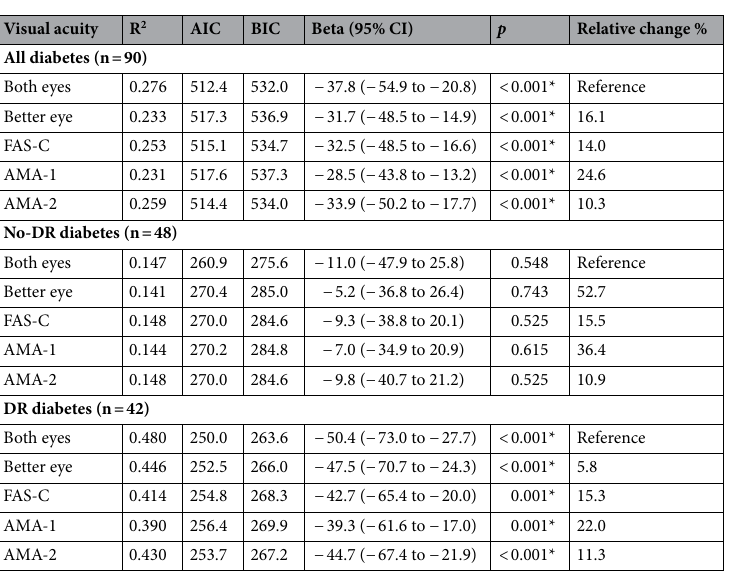
Table 4. Results of the multiple linear regression model and goodness-of-fit statistics of the different acuity models for the Rasch calibrated NEI VFQ-25 composite scores. AIC Akaike information criterion, BIC Bayesian information criterion, DR diabetic retinopathy, FVS‑C functional acuity score developed by Colenbrander, AMA‑1 early version of FAS algorithm developed by the American Medical Association, AMA‑2 new version of FAS algorithm developed by the American Medical Association. *Indicates significant p values ( p <